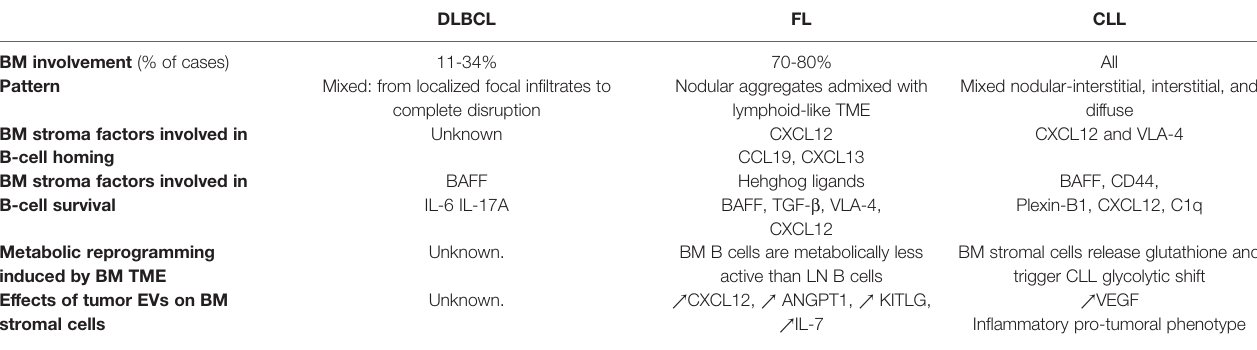
TABLE 1 | Key elements involved in the generation of B-cell non-Hodgkin lymphomas bone marrow supportive